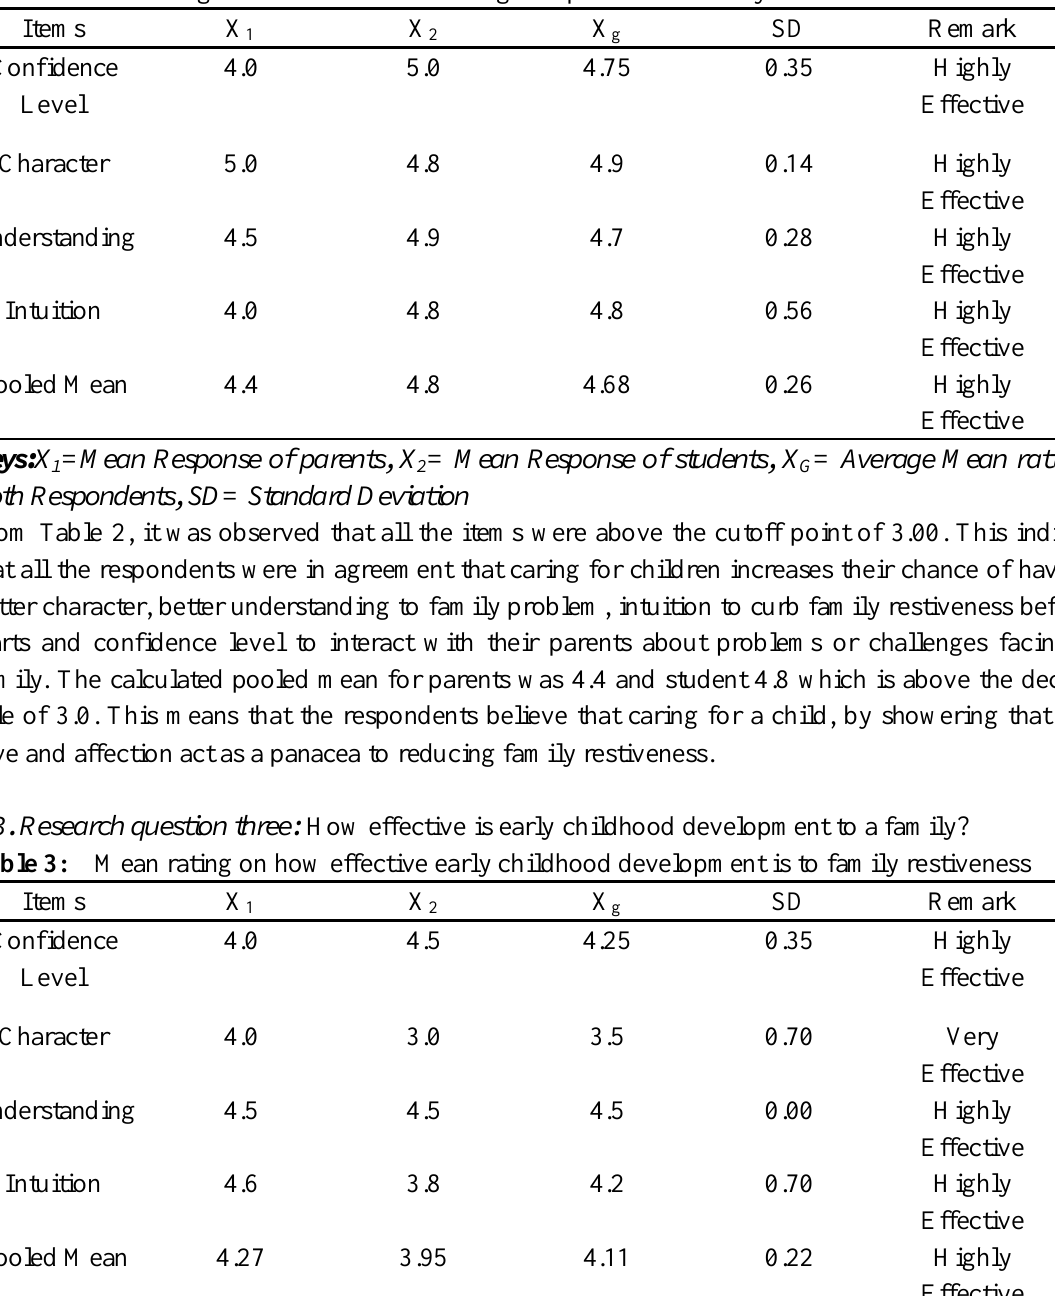
Table 2: Mean rating on how effective is caring as a panacea to family restiveness?